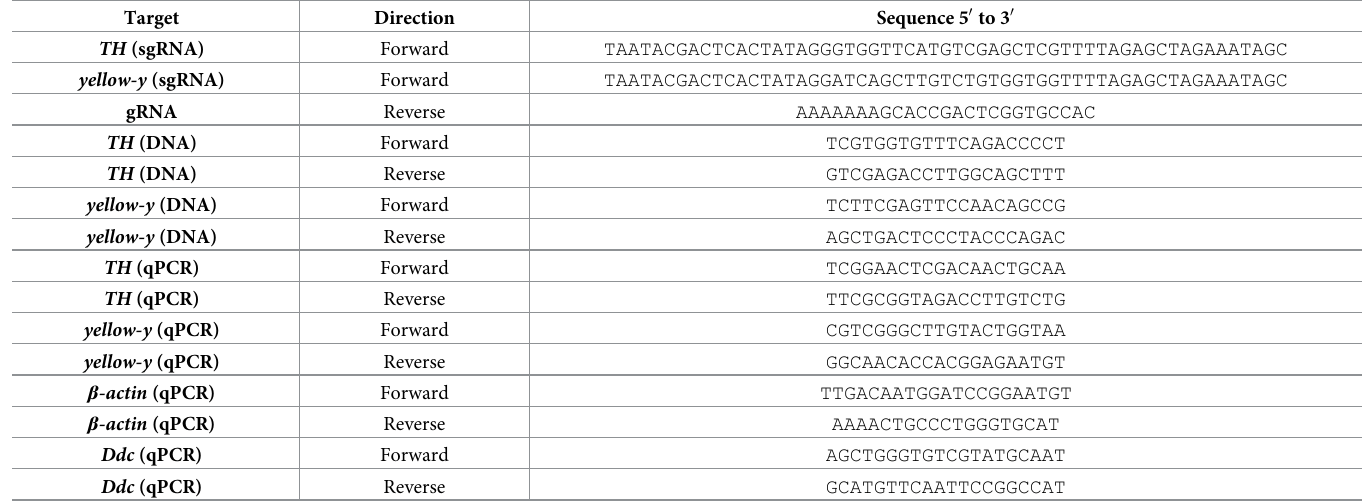
Table 1. Primer sequences used in this